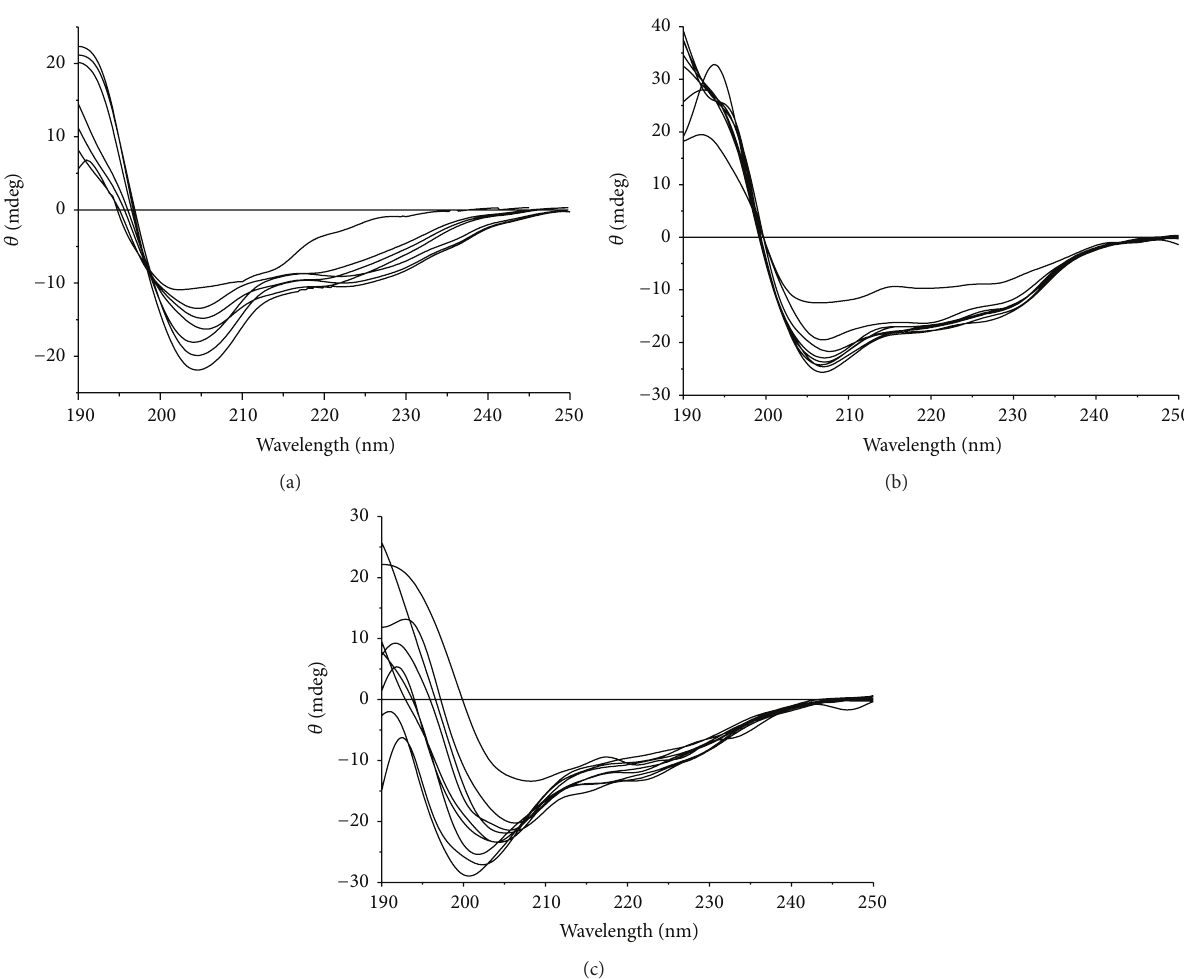
Figure 4: CD spectra of zinc finger proteins titrated by Zn 2+ . (a) ZNF191(243-368), (b) His 6 -ZNF191(243-368), and (c) ZNF191(243-368)-His 8 . The concentration of Zn 2+ is from 0 (up) to 10 𝜇 mol ⋅ L −1